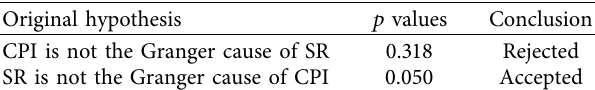
Table 9: Granger test results under linear cointegration hypothesis.